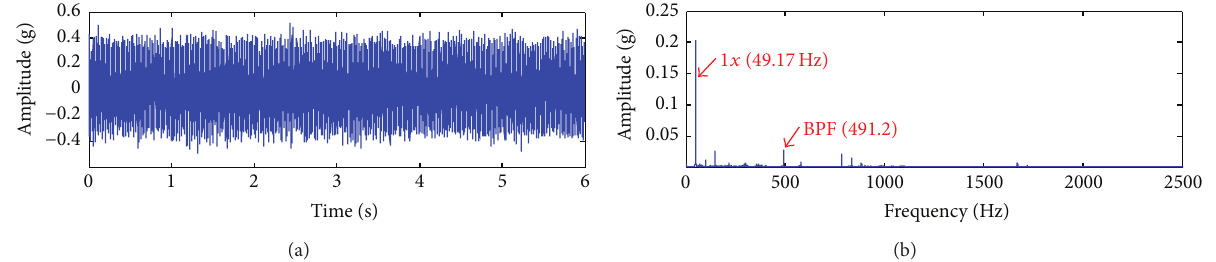
Figure 10: Original vibration signals under normal condition: (a) time-domain waveform and (b) frequency spectrum.